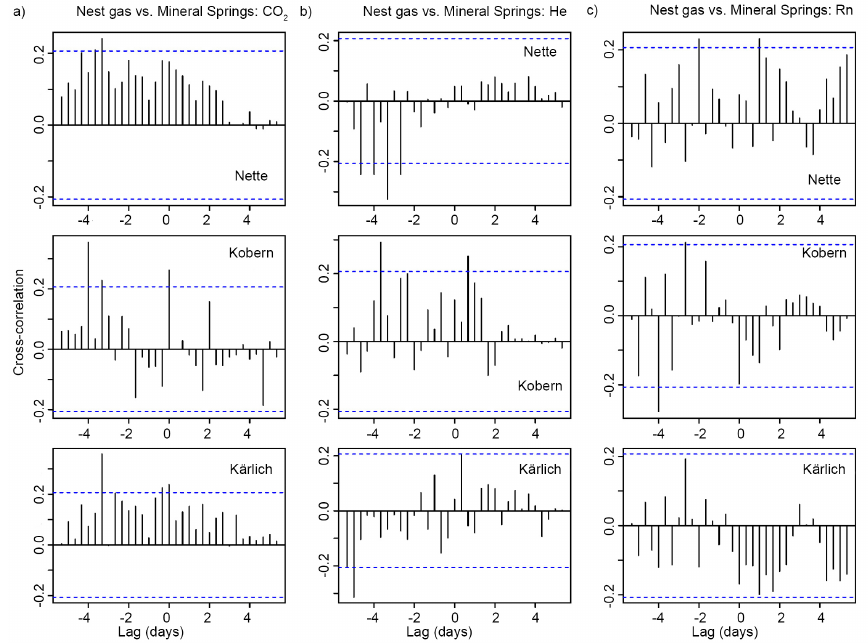
Figure A7. Cross-correlation of the time-series of NG vs. mineral springs (8-hour median smoothed) for ( a ) CO 2, ( b ) He, and ( c ) Rn for the 4-W samples. Blue dashed lines indicate confidence